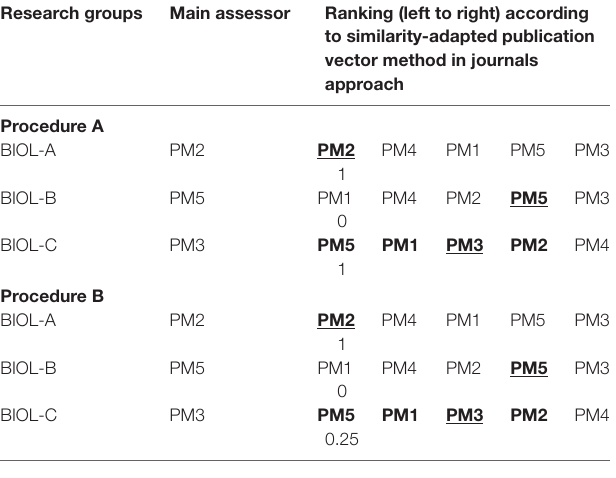
Table 2 | Illustrations of procedures A and